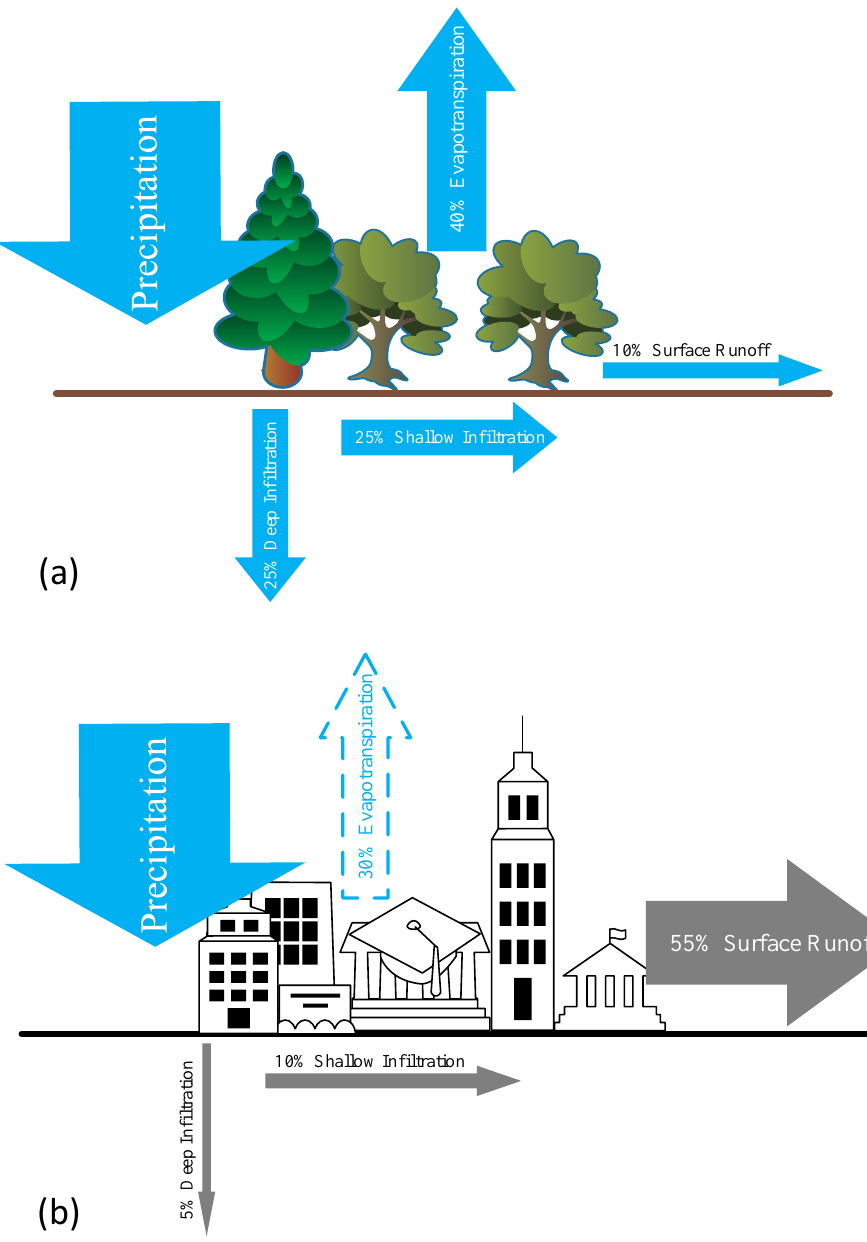
Figure 1. Water flow directions and percentages in ( a ) predevelopment, natural area; ( b ) urbanized area. (adapted from US EPA Report No. EPA 841-F-07-006) [10].